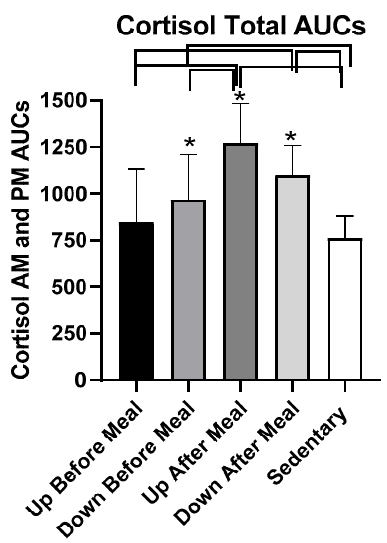
Figure 14. Total postprandial cortisol AUCs in the five trials. The AUCs in the two exercise-after-meals trials were higher than in the SED trial, and combined cortisol AUC in the UAM exercise-after-meal trial was higher than the exercise-before-meal UBM trial. There were no treatment differences within morning and afternoon cortisol AUCs. * indicates significant difference relative to groups marked by the overhead bracket